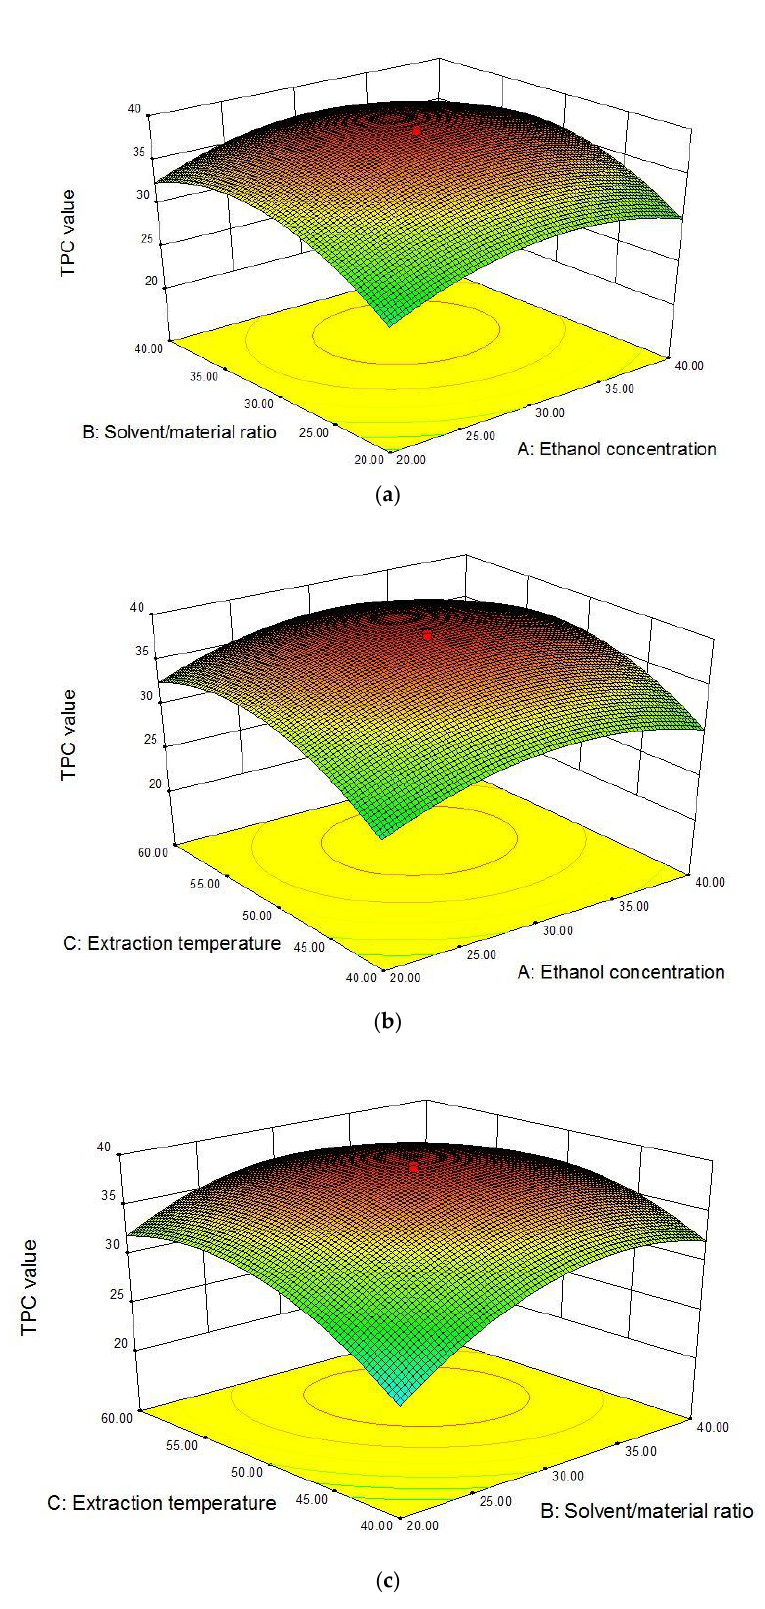
Figure 2. Graphical analysis of the effects of ethanol concentration (X 1 , %) and solvent/material ratio (X 2 , mL/g) ( a ); ethanol concentration (X 1 , %) and extraction temperature (X 3 , °C) ( b ); and solvent/material ratio (X 2 , mL/g) and extraction temperature (X 3 , °C) ( c ) on total phenolic content value (mg GAE/g DW).